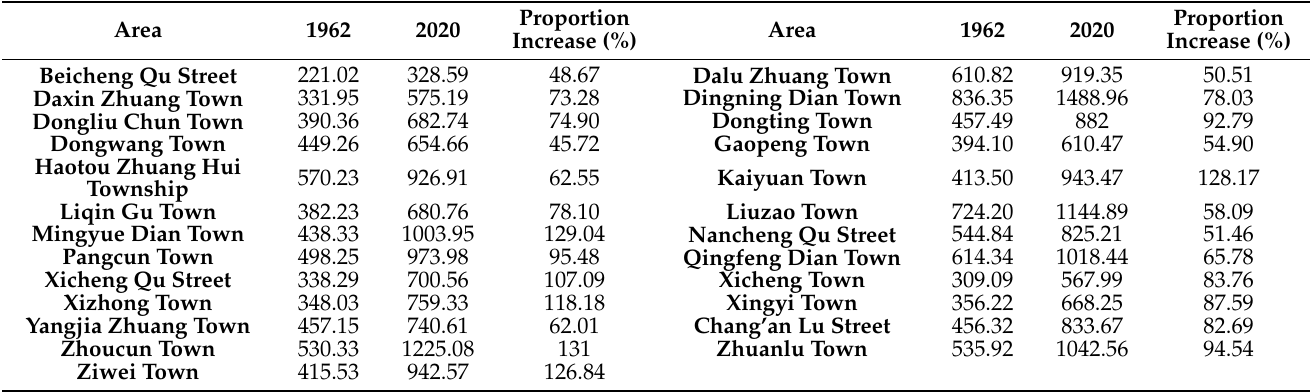
Table 2. Changes in the area of rural settlements in various townships in Dingzhou, China from 1962 to 2020 (unit: